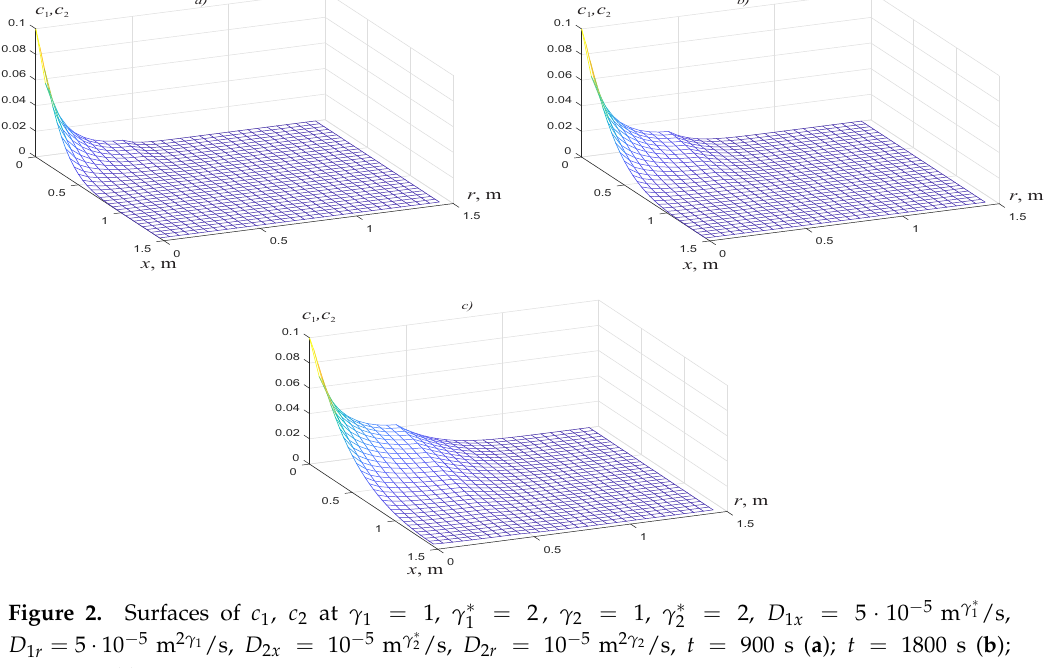
Figure 2. Surfaces of c 1 , c 2 at γ 1 = 1, γ ∗ D 1 r = 5 · 10 − 5 m 2 γ 1 /s, D 2 x = 10 − 5 m γ ∗ 2 /s, D 2 r = 10 − 5 m 2 γ 2 /s, t = 900 s ( a ); t = 1800 s ( b ); t = 3600 s ( c